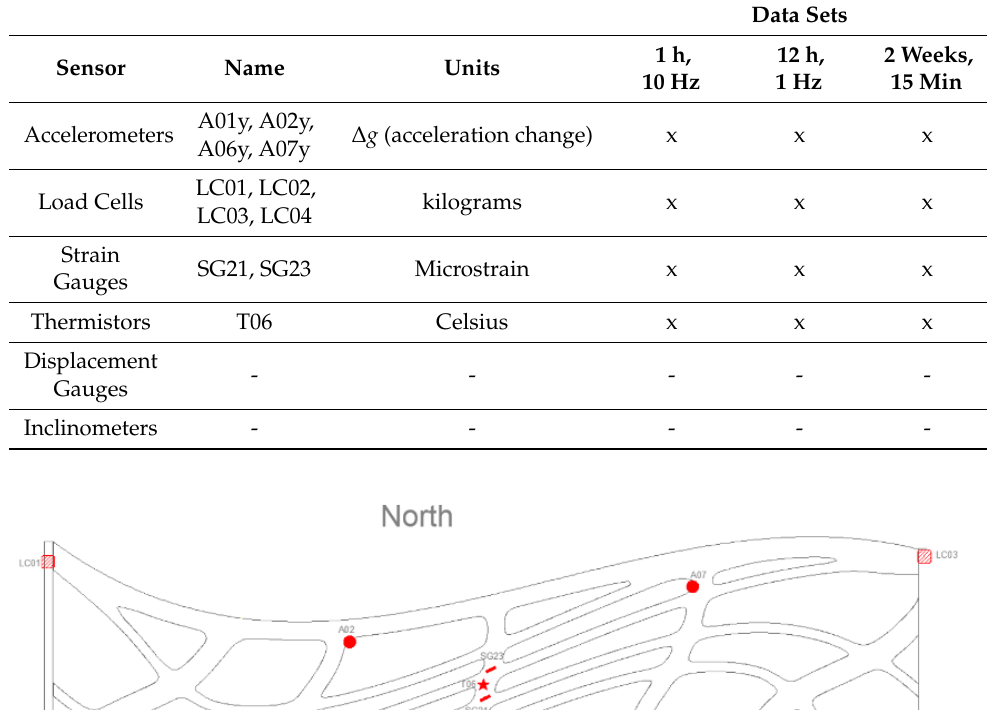
Table 1. Public Dataset Sensors and Data Frequencies.